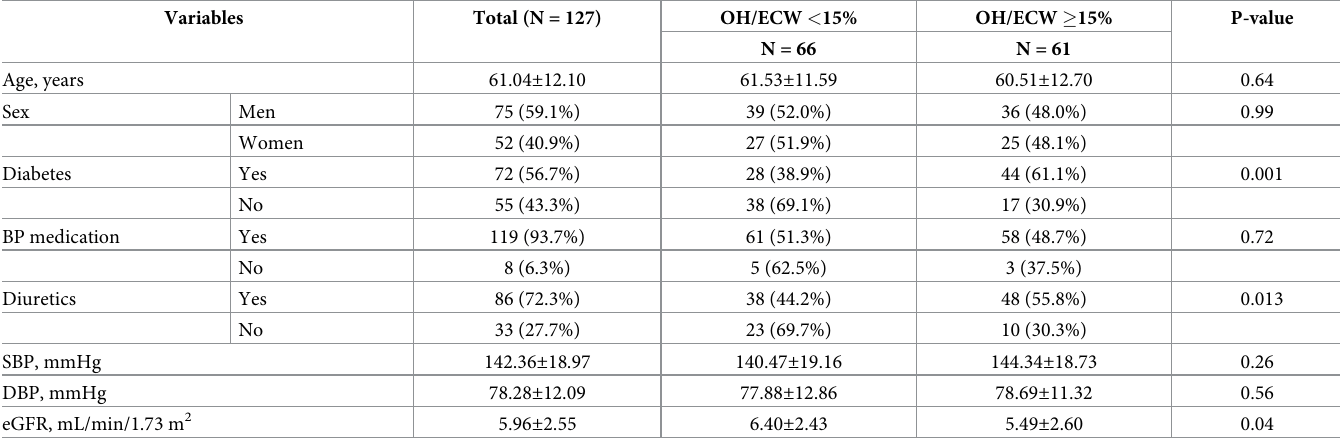
Table 1. Demographic findings of study